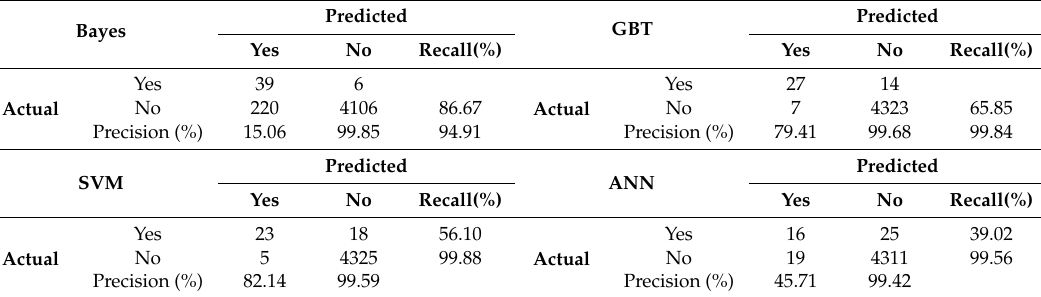
Table 7. Confusion matrices for the asbestos-cement pipes test sample.